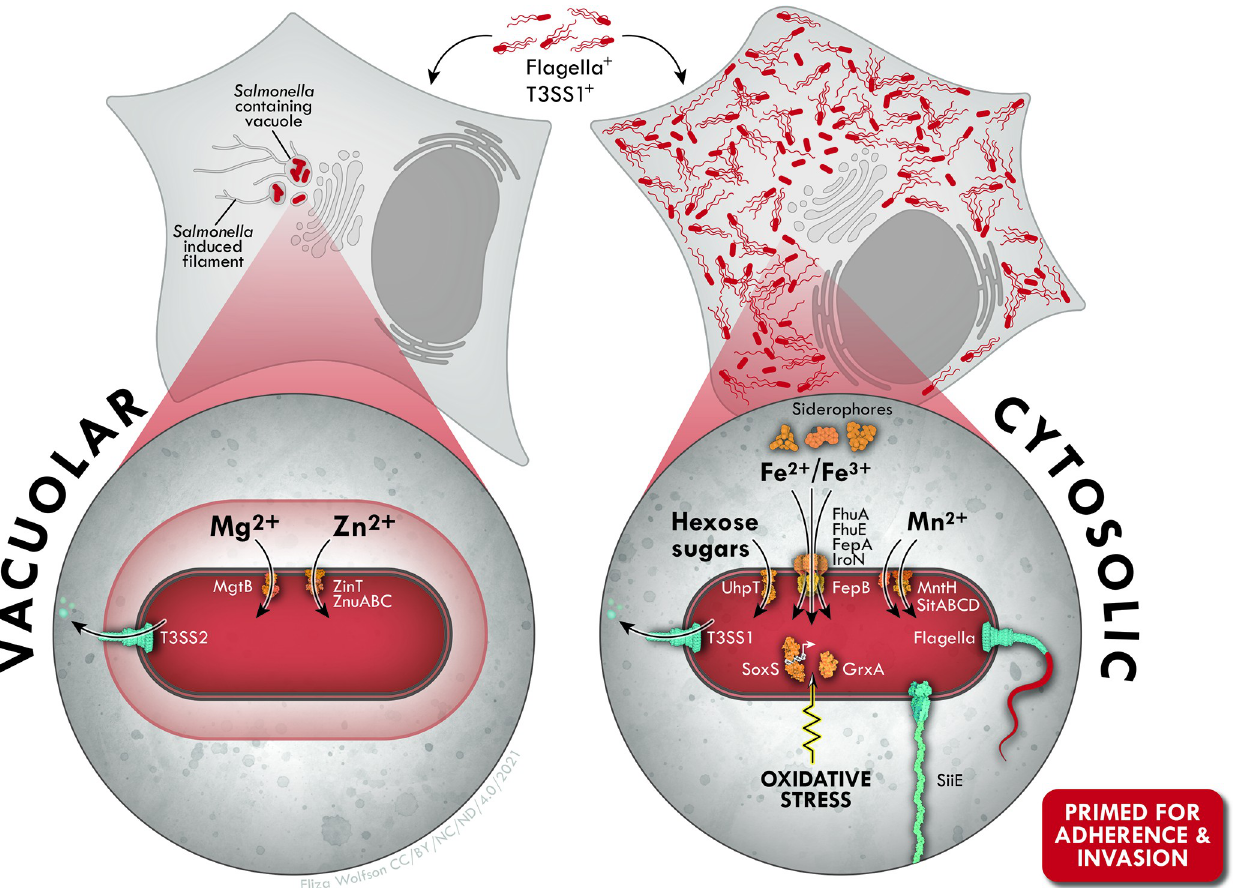
Fig 8. Adaptation to the epithelial cytosol requires extensive transcriptional reprogramming by S . Typhimurium. SCV-resident bacteria are translocating type III effectors via T3SS2, devoid of flagella and exposed to limiting zinc and magnesium concentrations. By contrast, cytosolic bacteria highly express genes implicated in iron uptake/storage, manganese and sugar transport suggesting that accumulation of these nutrients is important for bacterial proliferation in this compartment. Up-regulation of a subset of genes associated with oxidative stress resistance further indicates that bacteria are exposed to reactive oxygen species. Cytosolic bacteria are also T3SS1-active, flagellated and decorated with the MUC1-binding adhesin, SiiE, and therefore primed to adhere to, and enter, na ï ve cells upon their release.